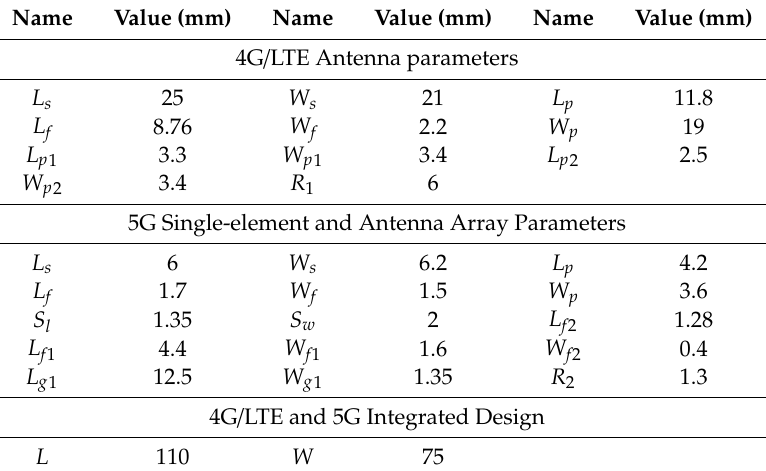
Table 1. Optimized Parametric Values of the Proposed